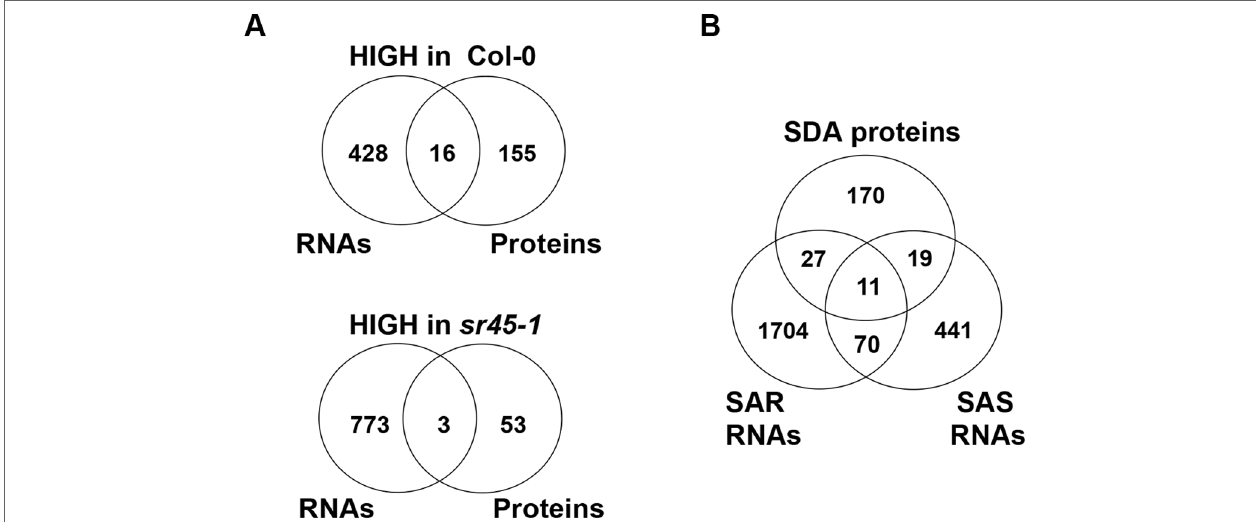
FIGURE 1 | An RNA-protein expression association study. (A) A comparison between SR45-differentially regulated RNAs and SR45-dependent differentially accumulated (SDA) proteins; (B) a comparison between SR45-dependent differentially accumulated (SDA) proteins, SR45-dependent alternatively spliced (SAS) RNAs and SR45-associated RNAs (SARs), published previously (Zhang et al., BMC Genomics, 2017).